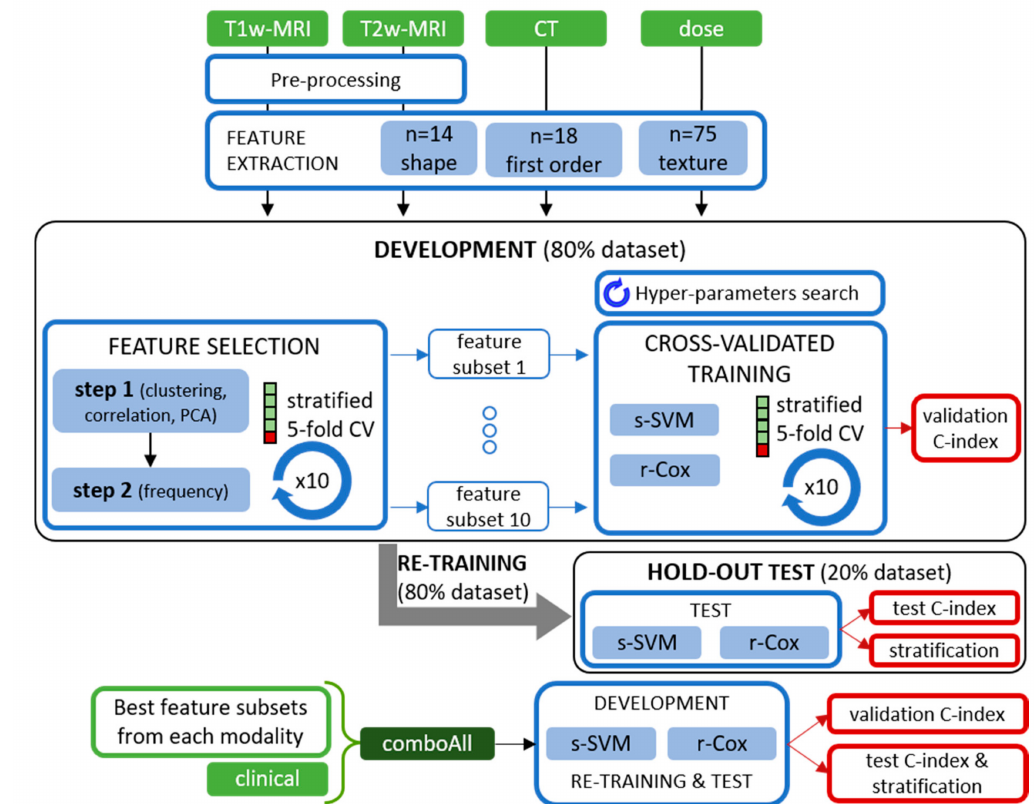
Figure 4. The proposed workflow. Green boxes highlight feature sources, blue boxes represent computational steps and red boxes results. Pre-processing steps are detailed in the supplementary materials, Section S1. A stratified five-fold cross-validation (5-CV) routine was repeated ten times and applied to the training set, for both feature selection and model training during the development phase. The hold-out test set was used to test the re-trained models in terms of models’ performance (test C-index) and ability to stratify patients in different survival curves according to their risk of undergoing an adverse LC